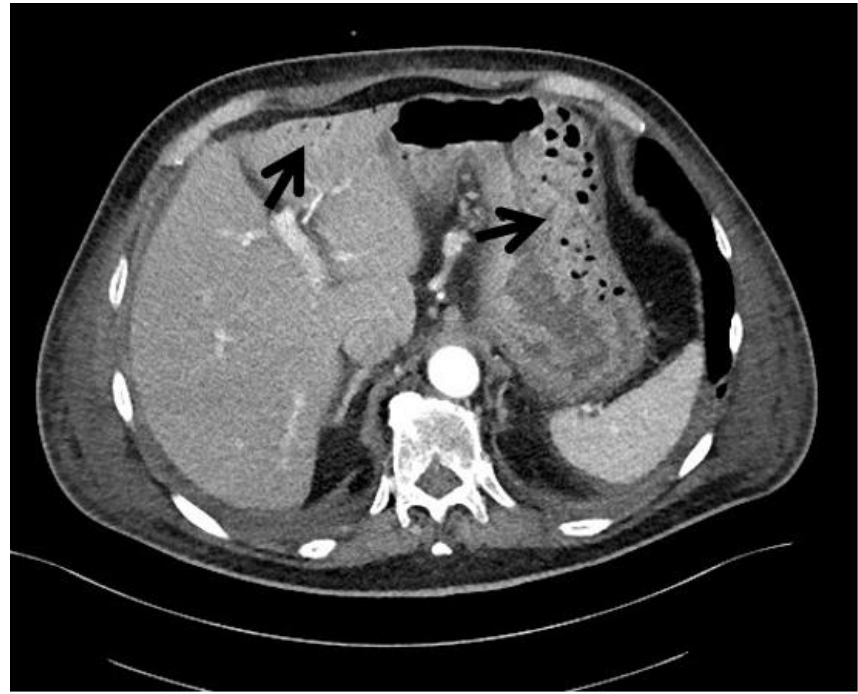
Figure 1. Radiological findings in a 79-year-old patient diagnosed at our institution with a gastrointestinal stromal tumor (GIST) and symptoms of abdominal pain. CT scan shows the presence of gas in the gastric wall at the greater curvature and in left intrahepatic portal system (black arrows). (Courtesy of Prof. Angelo Vanzulli, Radiology Department, Grande Ospedale Metropolitano